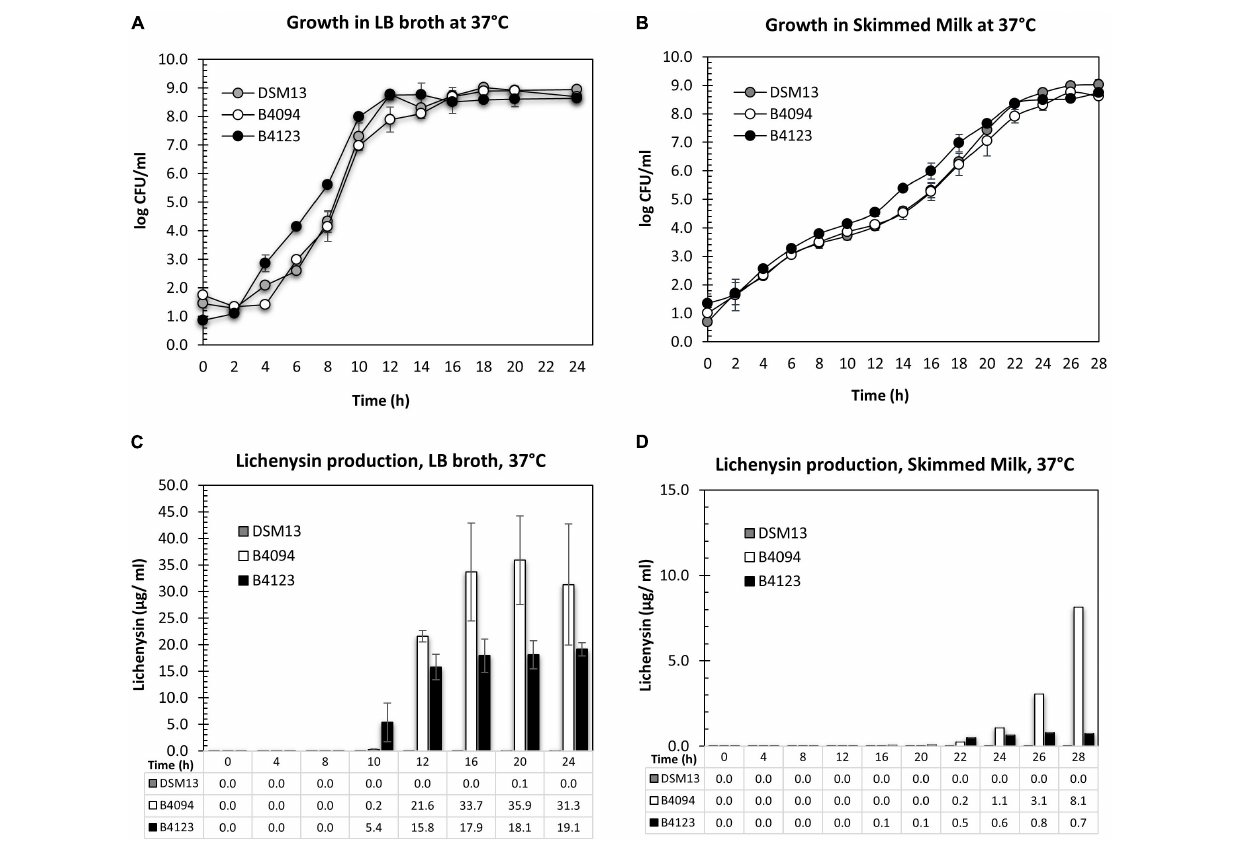
FIGURE 3 | Growth and lichenysin production for DSM13 T , B4094, and B4123 in LB and skimmed milk at 37 ◦ C. (A) Growth of three selected strains, DSM13 T , B4094, and B4123 in LB medium for 24 h. (B) Growth of three selected strains, DSM13 T , B4094, and B4123 in skimmed milk for 28 h. (C) Total lichenysin production ( µ g/ml) in LB broth for DSM13 T , B4094, and B4123. (D) Total lichenysin production ( µ g/ml) in skimmed milk for DSM13 T , B4094, and B4123. The amount of lichenysin produced by all three strains in LB at selected time points as quantified with RP-HPLC-QTOF-ESI/MS. Gray circle or bar- DSM13 T , white circle or bar- B4094, black circle or bar-